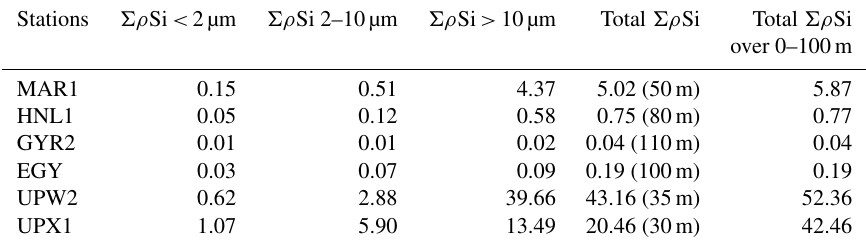
Figure 6. (a–b) Size-fractionated integrated biogenic silica ( (cid:54) BSi) standing stocks (0–125m) during the BIOSOPE cruise. UPW1 sta- tions was only integrated over 50m and UPX1 and UPX2 over 100m. Panel (b) shows a zoom over the central section where integrated BSi stocks are an order of magnitude lower than at the two extremities of the transect. Gray bars indicate that no size fractionation was conducted and represent the total (cid:54) BSi. (c) Size-fractionated integrated biogenic silica ( (cid:54) BSi) standing stocks (0–125m) during the OUTPACE cruise. Table 1. Size-fractionated integrated Si production rates in mmolSim − 2 d − 1 in the SEP (BIOSOPE). Integrated Si production was measured over the 0%–1% light depth range for each site (in parenthesis in column 5) and normalized over 100m, considering a zero production at 100m in the last